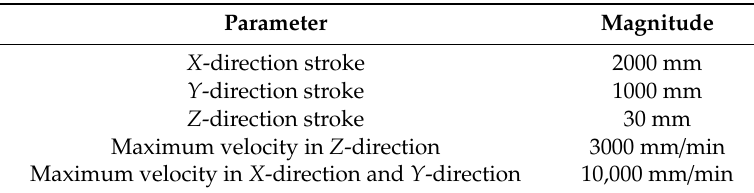
Figure 3. Structure of the dual-driving gantry-type machine tool (DDGTMT). Table 2. Parameters of the DDGTMT.